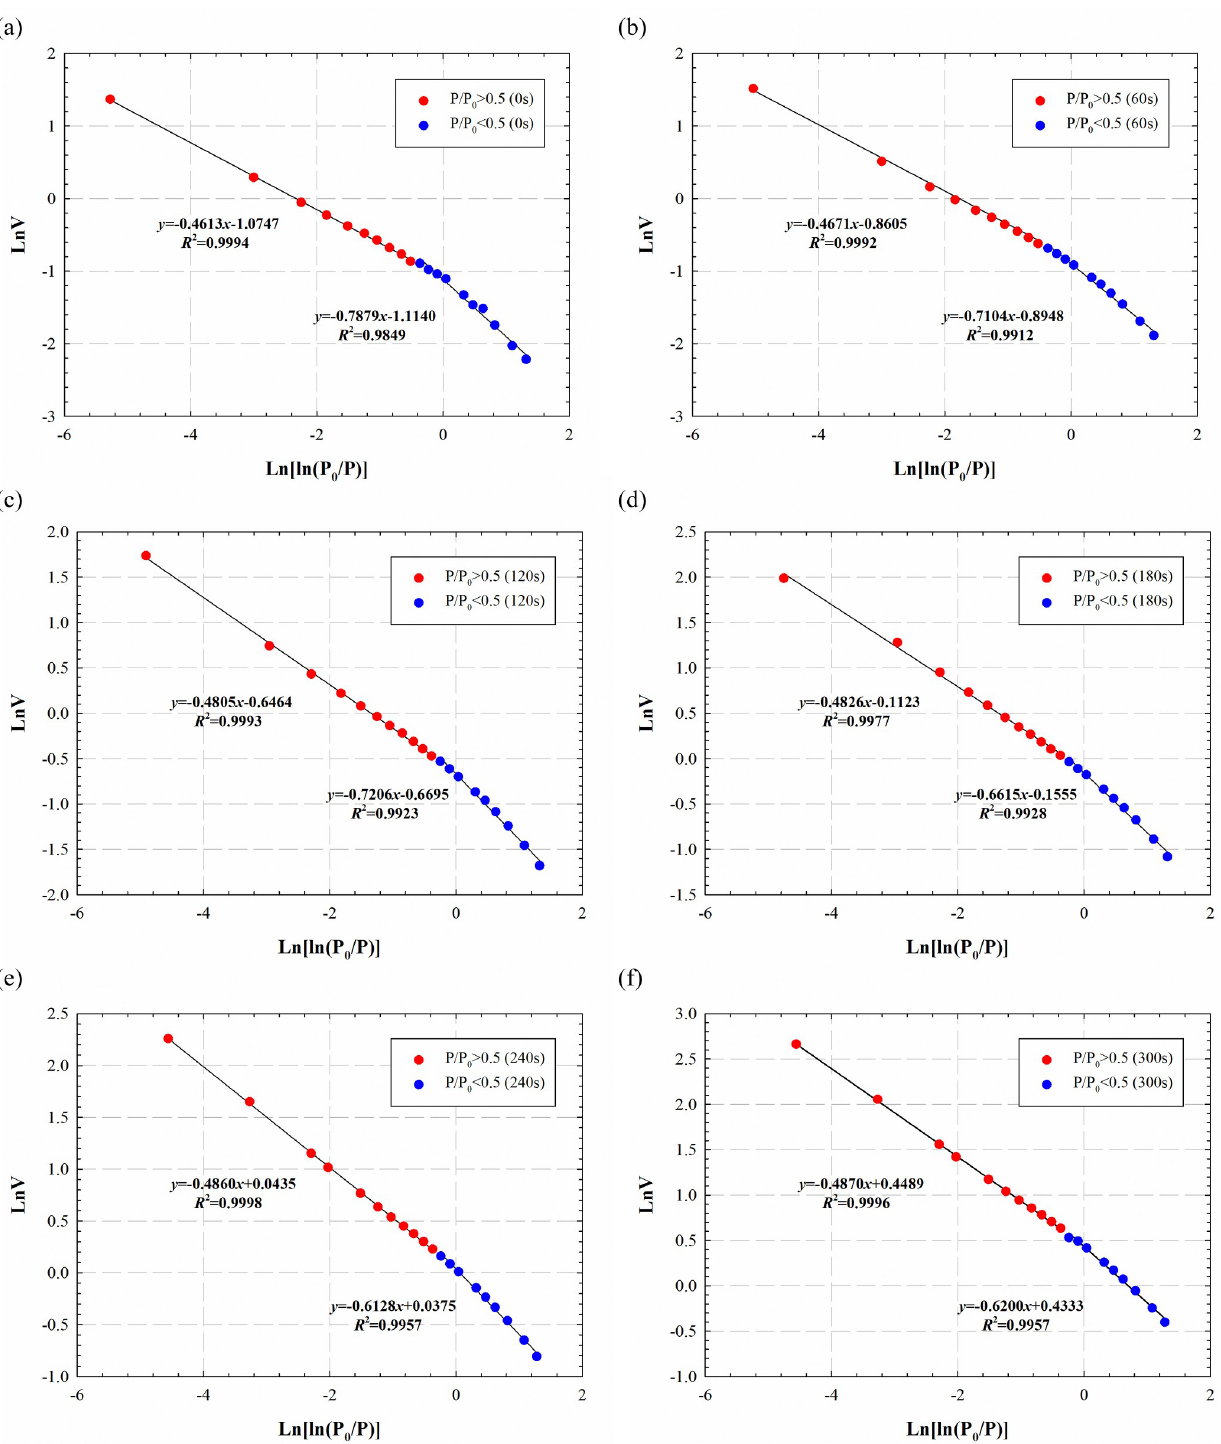
Fig 11. Relationships between Ln( V ) and Ln(Ln( P 0 / P )) fitted by the FHH model for marine shale samples at different electromagnetic radiation times. In these figures, the blue ones are used to calculate the fractal dimension D 1 , while the red ones are applied to calculate the fractal dimension D 2 .